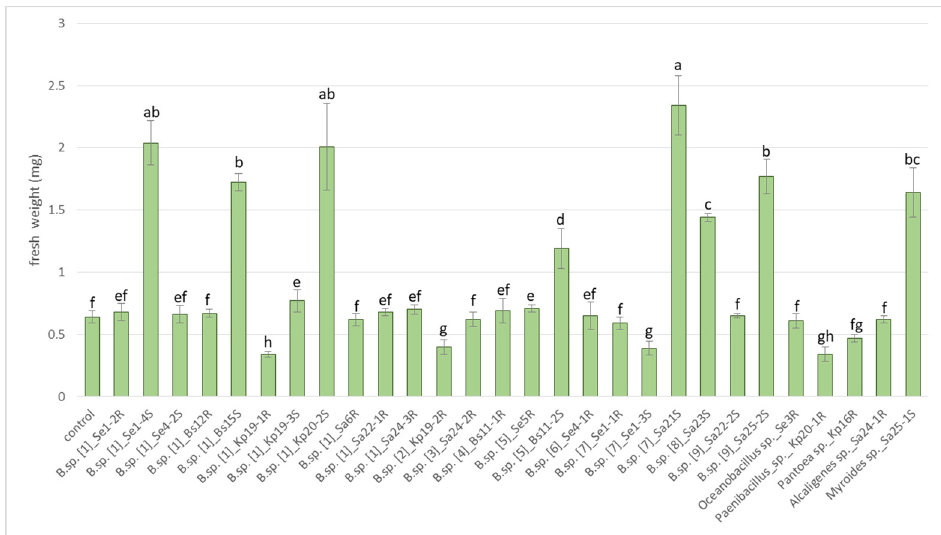
Figure 4. Effect of endophytes on fresh weight of lettuce seedlings cv. “Ducat”. ( average of three replicates ). Bars represent the mean ± SD of three different experiments, and different letters show a significant difference at the p ≤ 0.05 level, as determined by Duncan’s multiple test.